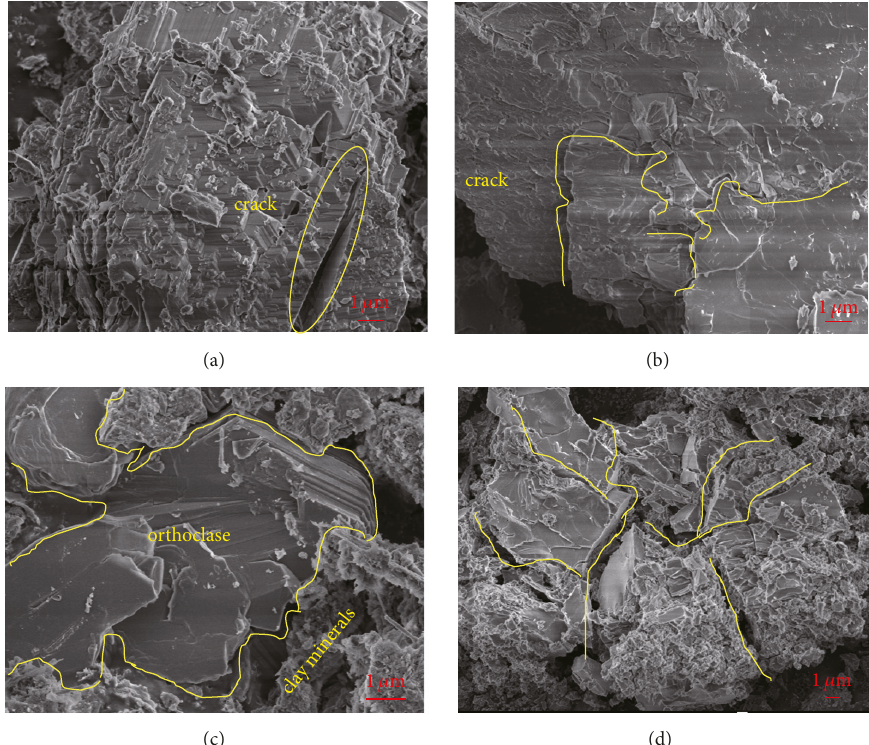
Figure 6: Typical microstructures of the mineral aggregates in